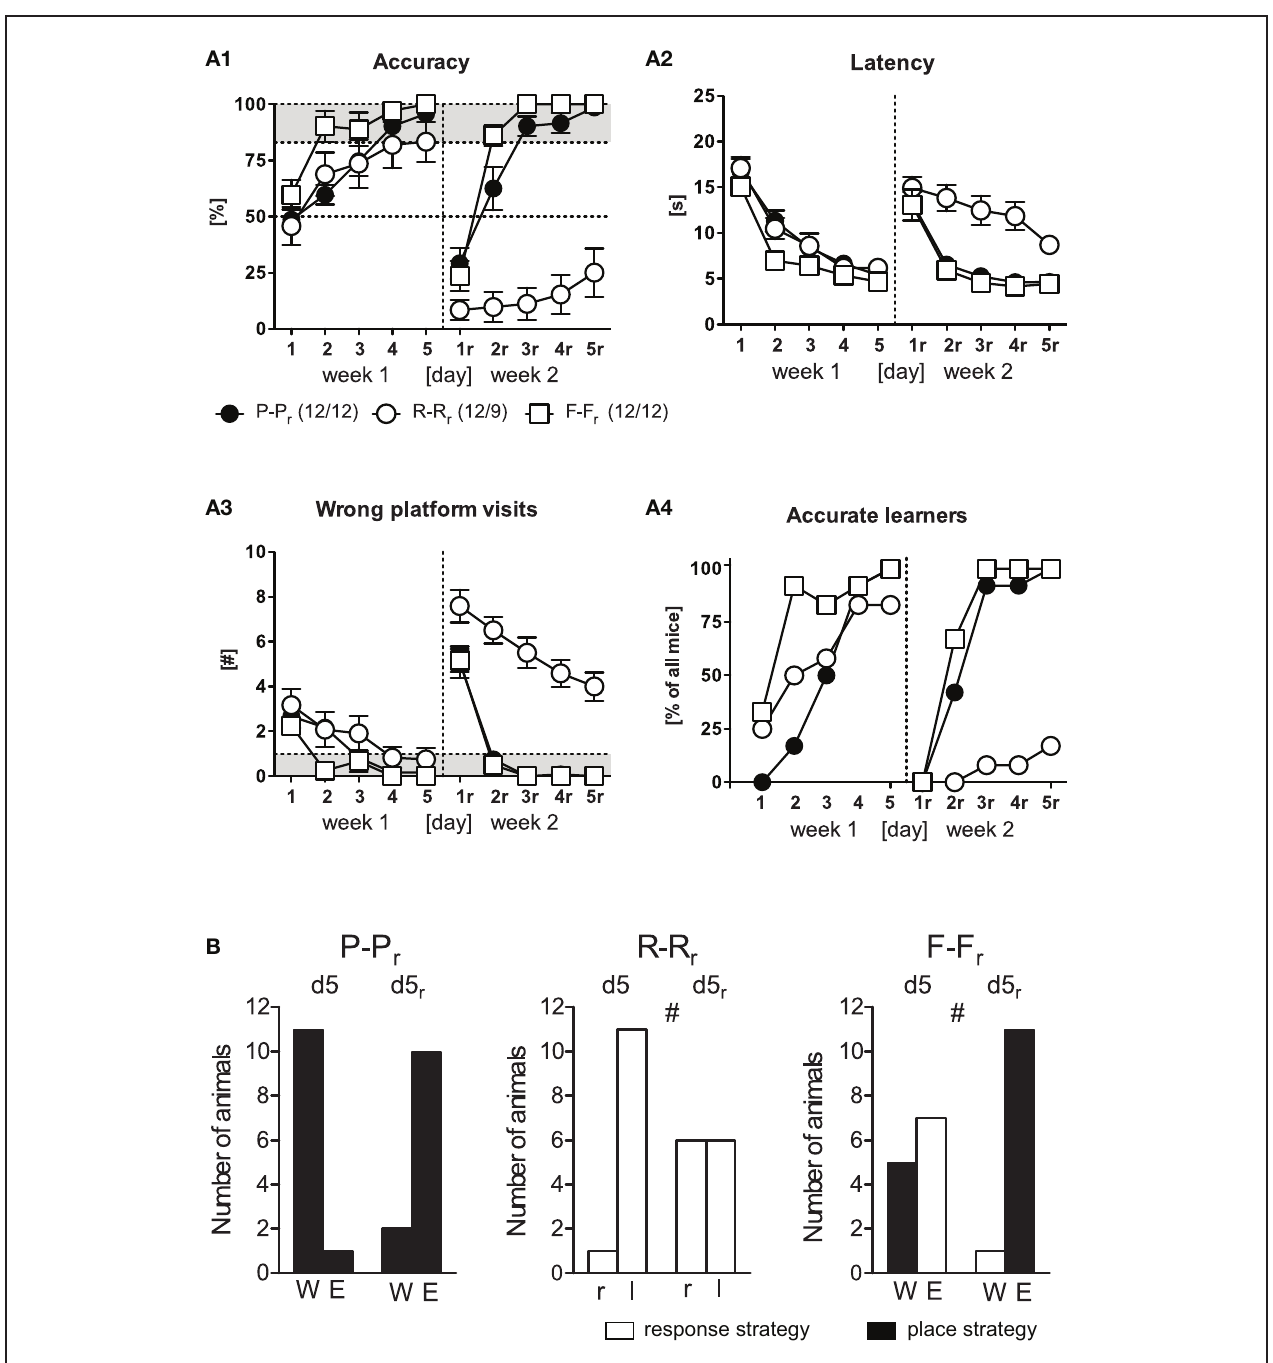
FIGURE 2 | Reversal learning. Three groups (P-P r , R-R r , F-F r ) underwent reversal learning with a probe trial in the end of each week. (A) In the 1st week, spatial learning occurred in all groups equally represented in all four learning parameter. In the 2nd week, only the accurate learners of week 1 of the R-R r group, but not of the P-P r and the F-F r groups, were unable to acquire the new platform position, as evident from decreased accuracy as well as increased latency and wrong platform visits [ Protocol: F ( 2 , 30 ) ≥ 22 . 09, p < 0 . 001, Protocol × Day: F ( 8 , 120 ) ≥ 2 . 86, p ≤ 0 . 006]. Merely 2/9 animals of the R-R r group reached the accurate learner criterion on d5 r . Performance parameters: (A1) Accuracy, expressed as the percentage of accurate trials per day. An accurate trial was defined